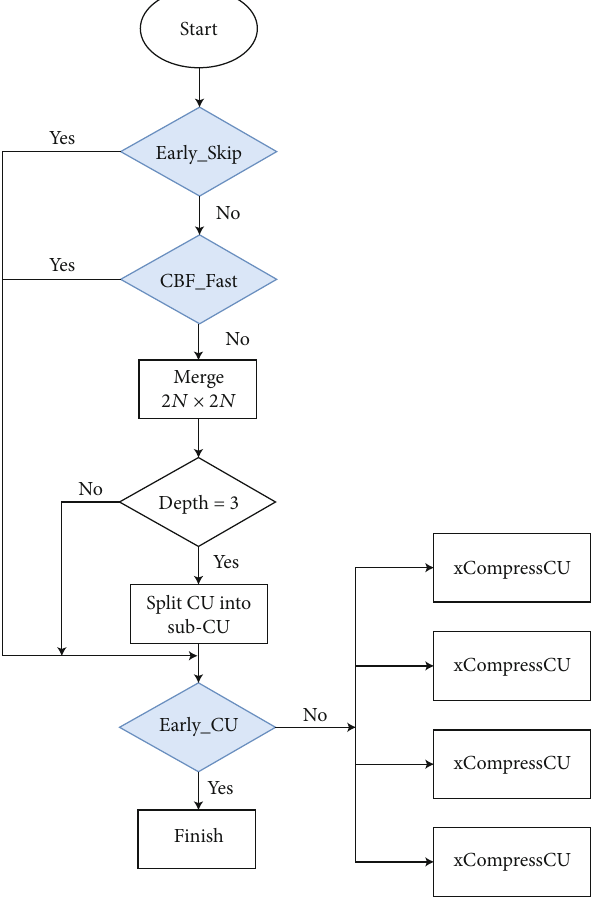
Figure 11: Flowchart of the mode decision